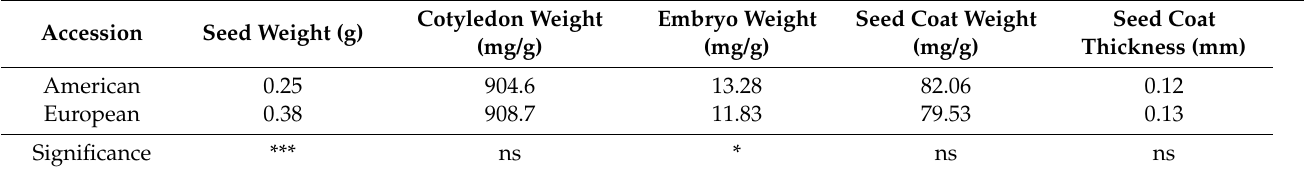
Table 3. Analysis of covariance for the mean morphological seed traits for the American and European accessions.